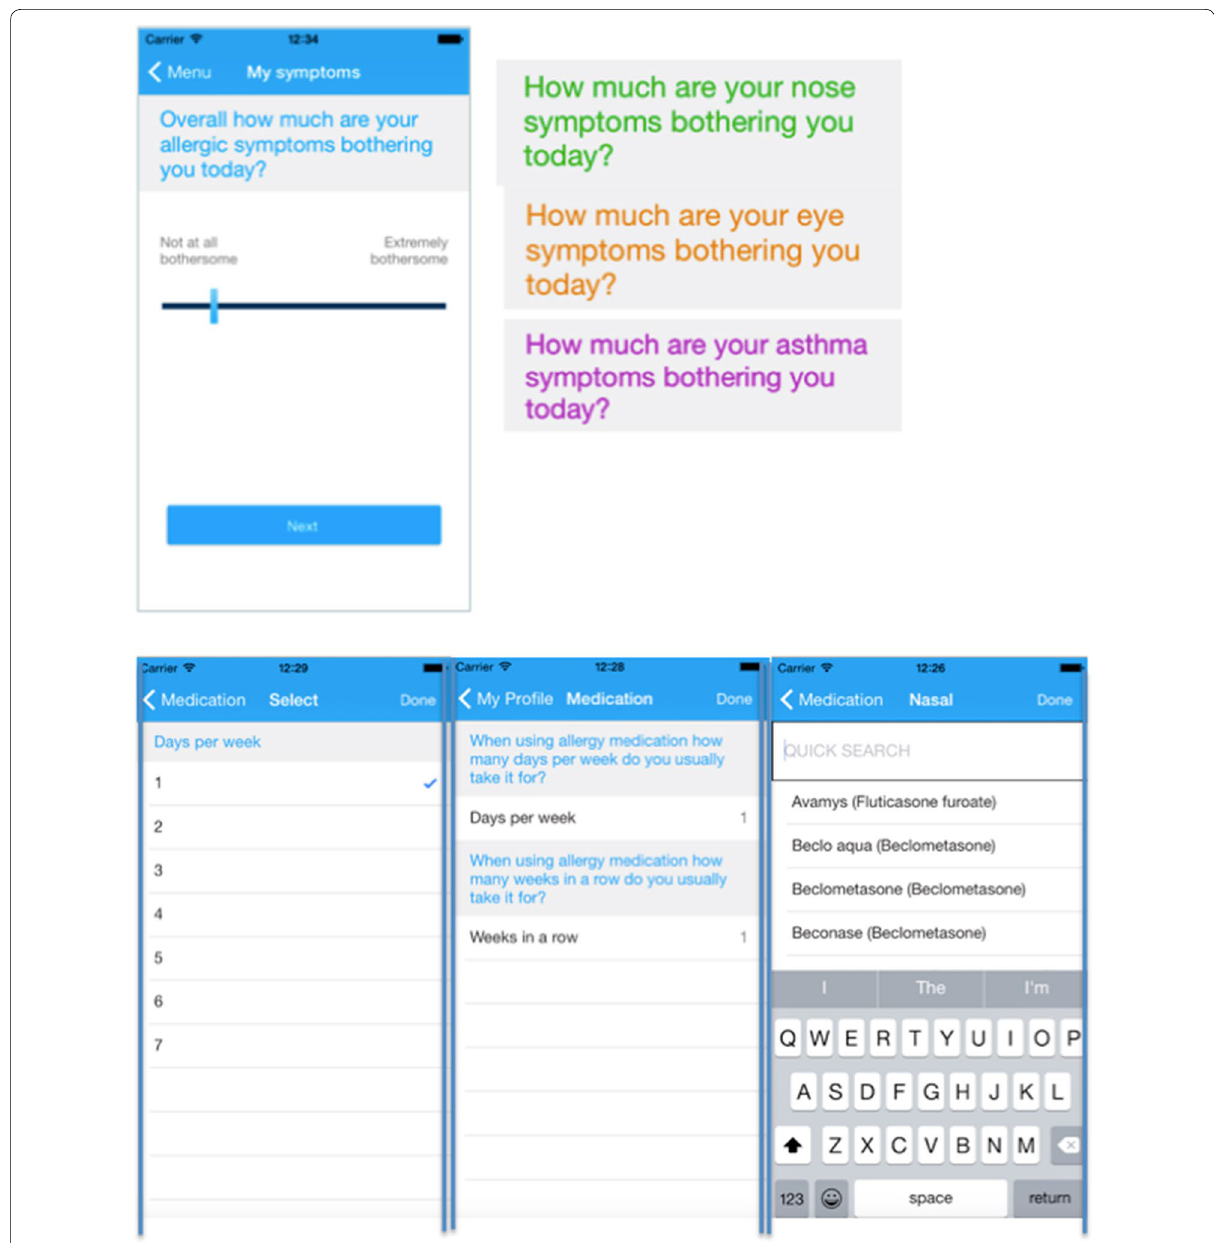
Fig. 1 Allergy Diary screens relating to Visual Analogue Scale and medications (from Bousquet et al.